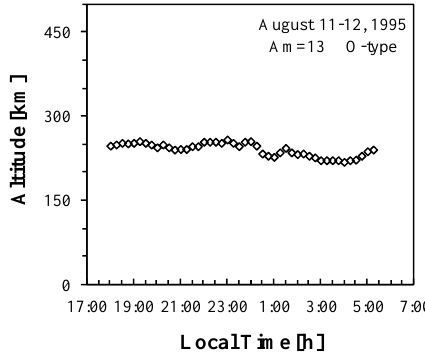
Figure 3. F-layer height variations as a function ofLT time with no significant motion. This pattern is termed O-type